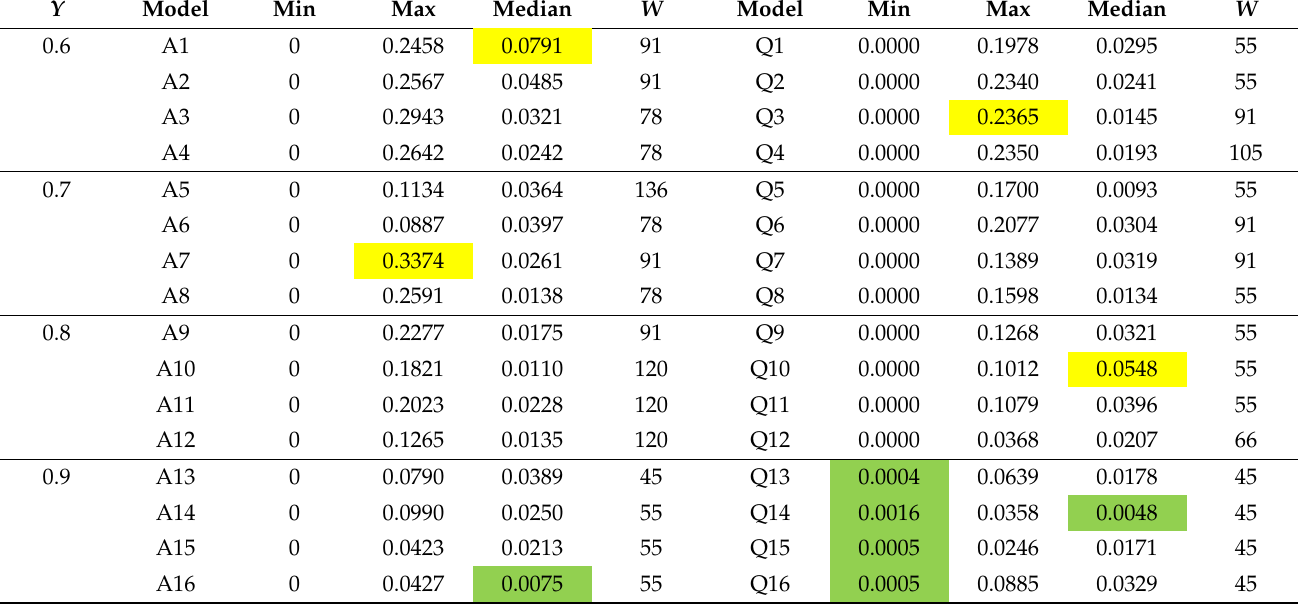
Table 13. Maximum and minimum RMSEweight results for models in both types of logic δ 1 2 SAT ρ , δ 2 2 SAT ρ and details by Wilcoxon test for